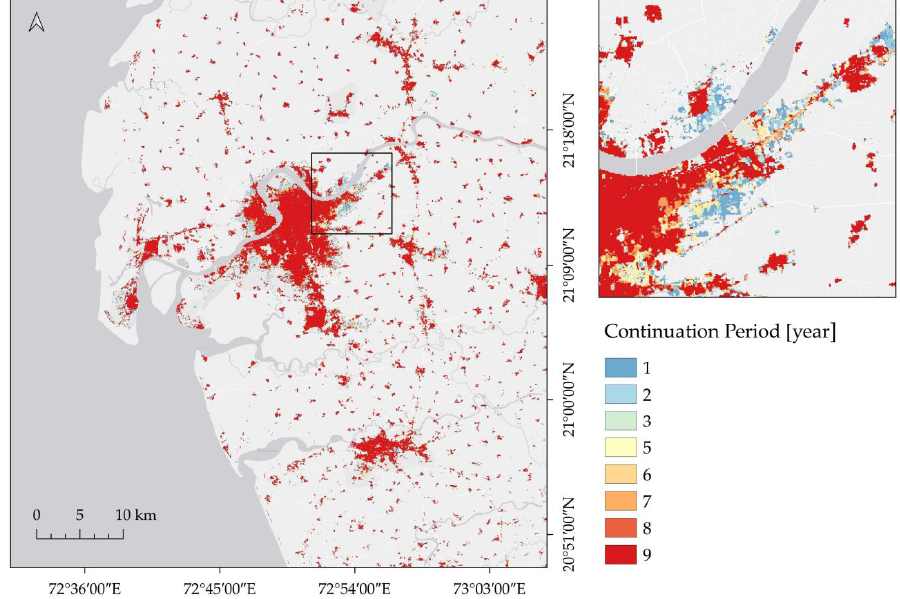
Figure 4. Continuation period layer for Surat, India, generated from the annual WSF-evolution layers of Surat (2001 to 2010).